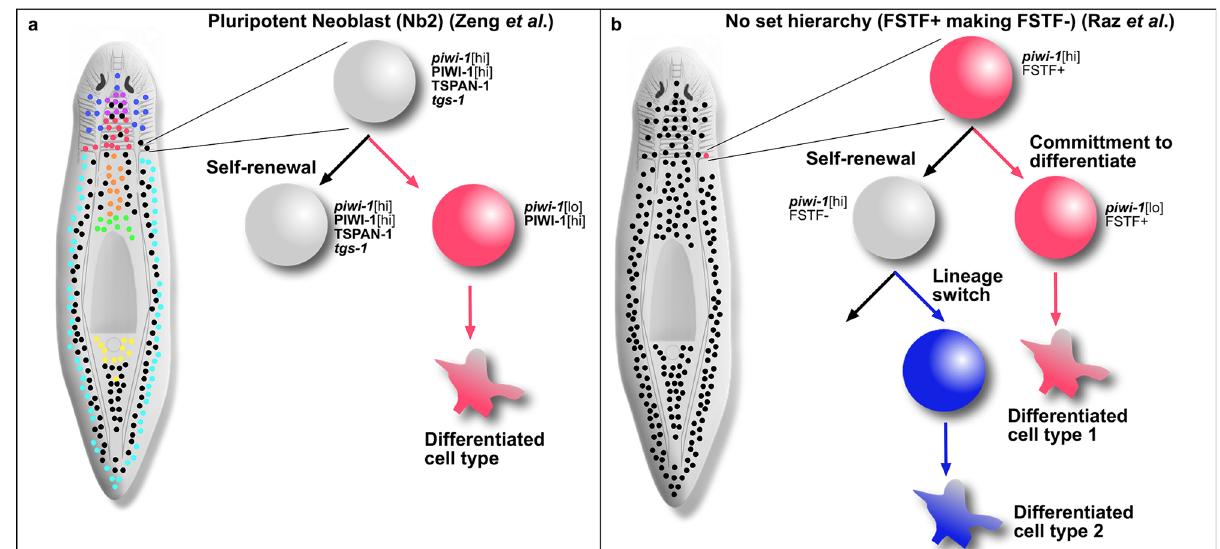
Fig. 2 Possible interpretations of potency in planarians. a Zeng et al., suggest that the Nb2 in silico cluster of neoblasts is the pluripotent population in planarians, which can be prospectively puri fi ed by TSPAN-1 protein expression and transplanted into hosts devoid of stem cells. Nb2 cells are distributed throughout the body axis (black dots) and specialized subtypes of neoblasts (various colored dots) are made from them in a traditional hierarchy. b Raz et al., show that although neoblasts can express factors that make them appear specialized (pink dot; FSTF + ), they in fact can give rise to pluripotent- looking neoblasts (black dots; FSTF − ), which then make different lineages as well (blue). In this case, a neoblast may appear specialized (pink dot), but it can readily switch back to pluripotent state (black dots). It is a combination of cell cycle stage and down-regulating piwi-1 transcript the authors propose leads to true lineage